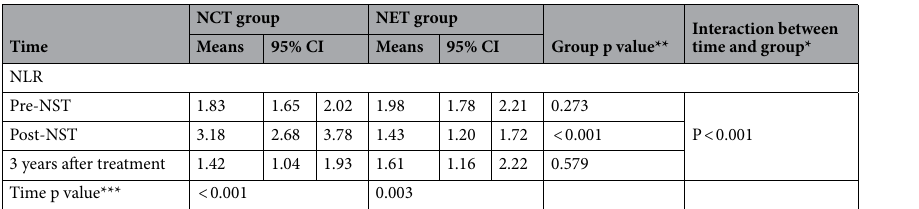
Table 6. NLR changes after neoadjuvant systemic treatment. NLR Neutrophil-to-lymphocyte ratio, NST Neoadjuvant systemic treatment, NCT Neoadjuvant chemotherapy, NET Neoadjuvant endocrine therapy. *Indicates a significant difference between NCT and NET groups in changes over time. **Comparison between two groups by specific time. ***Significance of changes over time for each group.